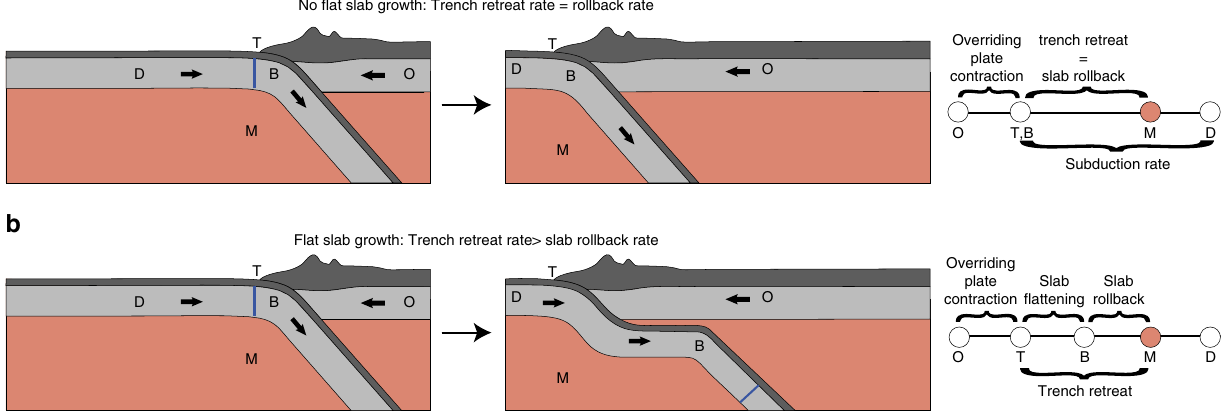
Figure 2 | Conceptual model of flat slab flat slab subduction in a mantle reference frame. We distinguish the kinematic vectors of the Overriding plate (O), the Downgoing plate (D), the Trench (T), the slab Bend (B) and the sub-lithospheric upper Mantle (M) in a 2-D trench-perpendicular cross section. Trench T is the intersection between the subduction thrust and the sea floor. Slab bend B is the hinge between the (sub-)horizontal and dipping slab segments. In cases of flat slab subduction B is separated from T by zone of low-angle subduction. Left, Middle panel: plates in a cross-sectional view at the onset and after a period of overriding plate advance, respectively. Right panel: plates and plate boundaries on a velocity line, where M is our reference, illustrating the following relationships: the difference between motion vectors of overriding and downgoing plate is the plate convergence rate (O minus D); of trench and downgoing plate is the subduction rate (T minus D); of trench and overriding plate is the overriding plate shortening rate (T minus O); of slab bend and trench is the flat slab formation rate (T minus B); of trench and mantle is the trench retreat rate (T minus M); and of slab bend and mantle is the slab rollback rate (B minus M). ( a ) subduction of D underneath O. T and B have the same relative velocity with respect to M, i.e., trench retreat equals slab rollback. The higher velocity of O relative to M is accommodated by overriding plate shortening. The blue line on the downgoing plate is a marker to indicate the lithosphere that is located at the trench at the onset of overriding plate advance. ( b ) represents subduction of a flat slab, whereby T has a higher relative velocity than B. In this example, both retreat relative to M. Trench retreat exceeds slab rollback, flat slab forms. The rate of subduction exceeds the rate of flat slab formation: the blue line passes both the position of the trench and the slab